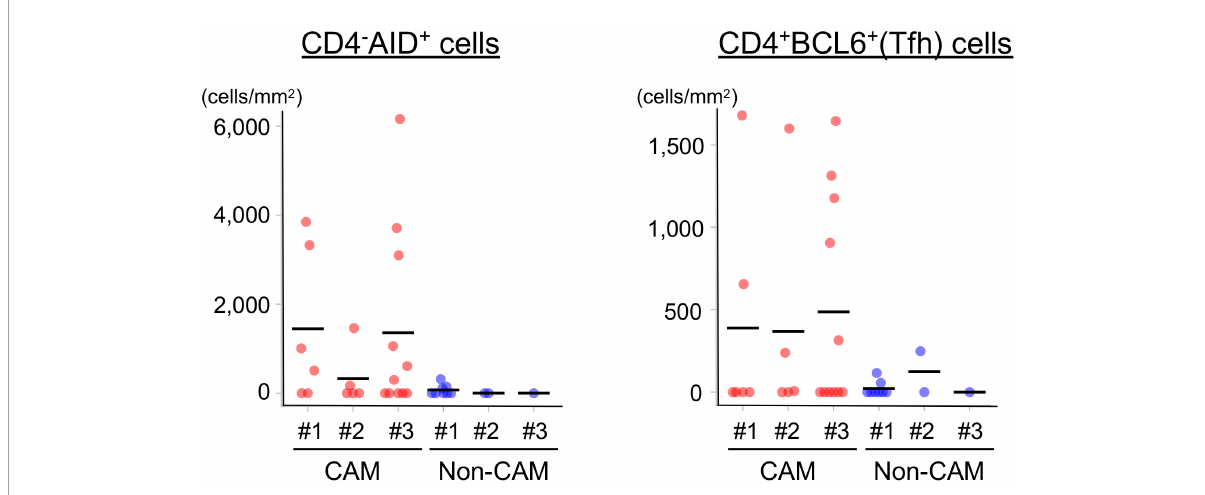
FIGURE9 Density of CD4 − AID + class-switched B cells and CD4 + BCL6 + Tfh cells in the TLSs from CAM patients and non-CAM controls. The density of CD4 − AID + class-switched B cells and CD4 + BCL6 + Tfh cells in the TLSs from 3 CAM patients and 3 non-CAM controls was analyzed by computerized quantitative assessment using the bioimage analysis software QuPath. The horizontal lines indicate the mean. BCL6, B-cell lymphoma 6; TLSs, tertiary lymphoid structures; CAM, cancer-associated myositis; AID, activation induced deaminase; Tfh, T follicular